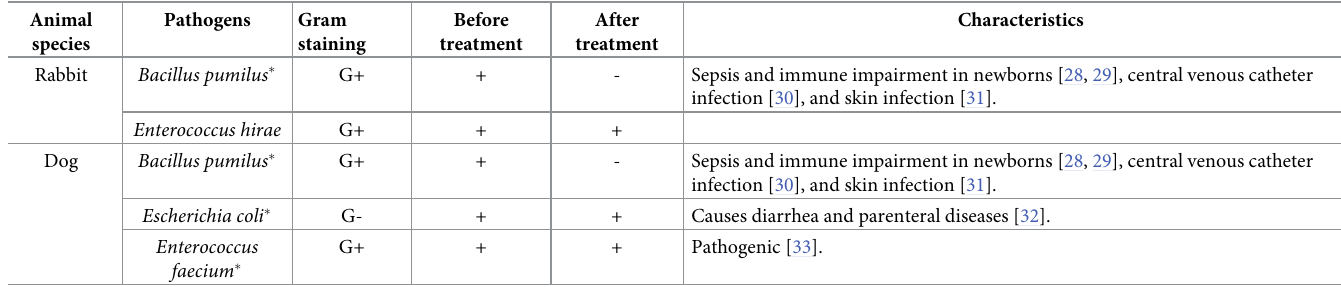
Table 4. The impact of ozone treatment on pathogens in the feces of rabbits and dogs. Animal species